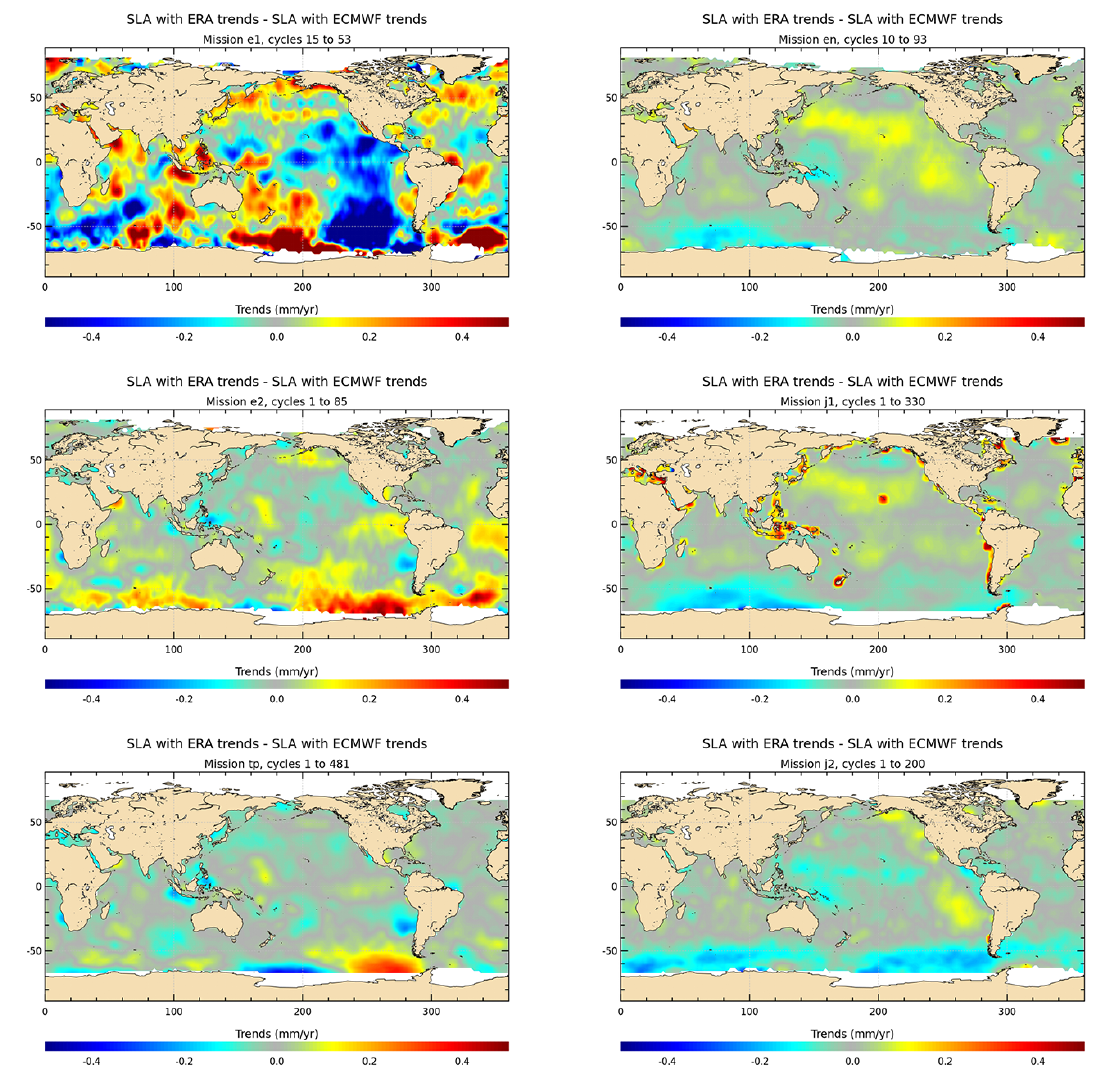
Figure 13. Maps of MSL trend differences successively using the DT correction derived from ERA-Interim and from ECMWF operational pressures fields (reference) for ERS-1, ERS-2, and TOPEX (on the left), for Envisat, Jason-1, and Jason-2 (on the right) (mmyr − 1